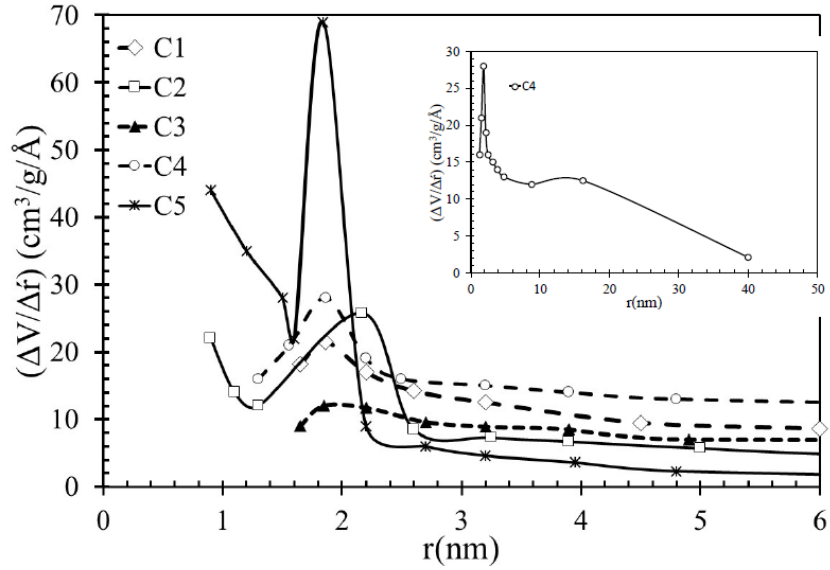
Figure 5. Pore size distribution curves for in the study clays.